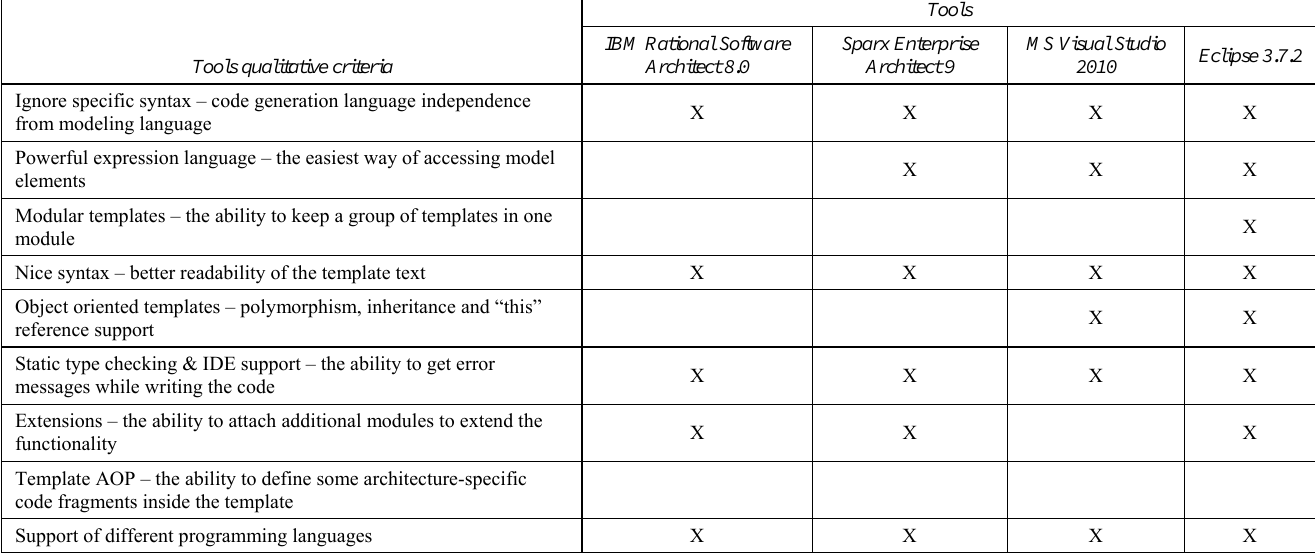
R ELATION OF THE Q UALITATIVE C RITERIA AND C ODE G